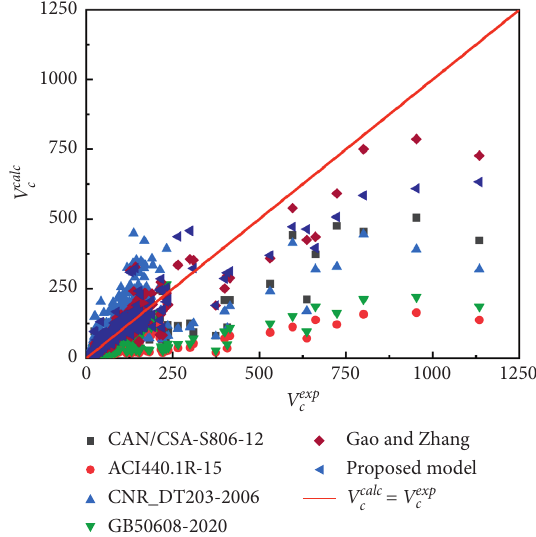
Figure 3: Comparison of V calc